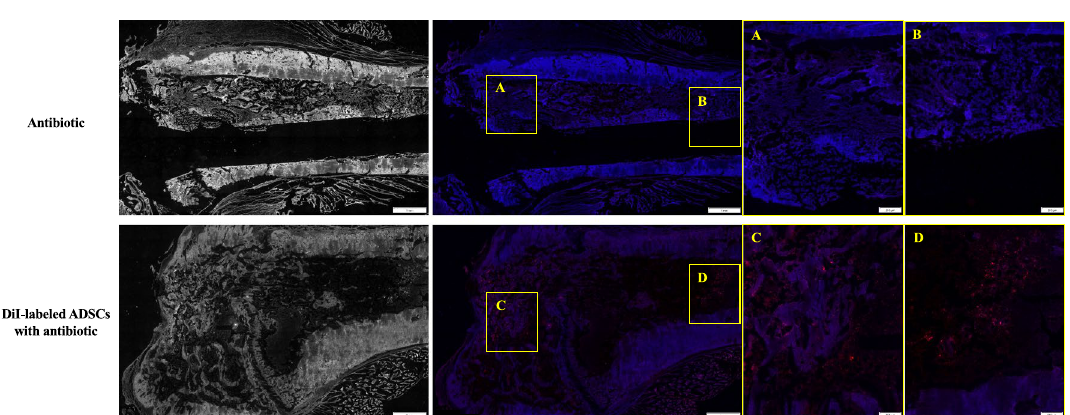
Figure 8. Representative images of DiI labeling at the site of infection. Frozen sections were prepared from rats in the antibiotic group not injected with labelled cells ( top ) , and 14 days after transplantation of ADSCs labeled with DiI ( bottom ) (1 of the 3 rats per group, with similar results). For identification of tissues following DiI labeling, the gray-scale scale (16 bit) of the DiI-labeled section was used. On POD14, DiI-positive (red) cells were distributed through the trabecular bone around the K-wire. ( A ), ( B ), ( C ), and ( D ) represent high- magnification images of the boxed regions. ADSC adipose-derived mesenchymal stem